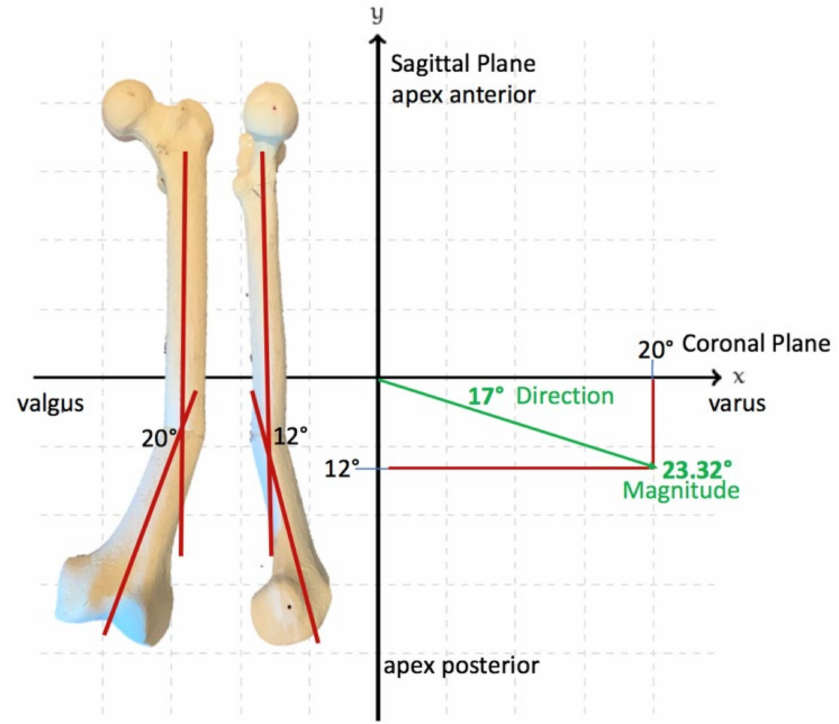
Figure 2. Determining the plane of the deformity. The plane of deformity can be calculated by plotting the measured deformity in the coronal and sagittal planes on the x and y axes, where the magnitude of the true deformity is the length of the resultant vector attained from the plot of the coronal and sagittal vectors. The location of the true deformity plane is the direction of this resultant vector with respect to the coronal or sagittal plane. This calculation can be done with a ruler and compass or, more accurately, using basic geometric principles. In the example shown, the maximum deformity is 23.32 degrees, and this deformity plane is located between the coronal and sagittal planes, 17 degrees from the coronal plane rotating posteriorly towards the sagittal